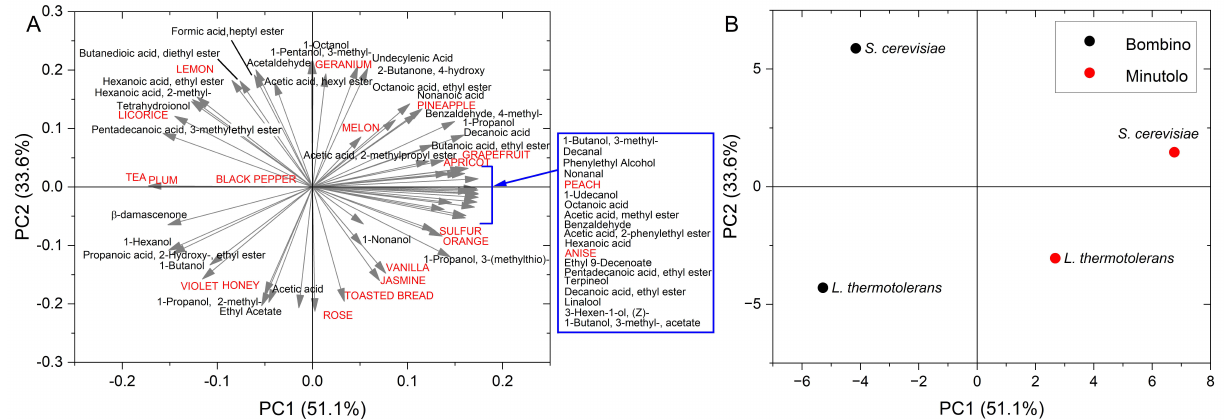
Figure 6. Principal component analysis (( A )—loading plot, ( B )—score plot) of the volatile com- pounds (in black) and frequencies of sensory attributes (in red) of the wines obtained by the combi- nation of grape cultivars (Minutolo and Bombino) and yeast starters ( Saccharomyces cerevisiae and Lachancea thermotolerans